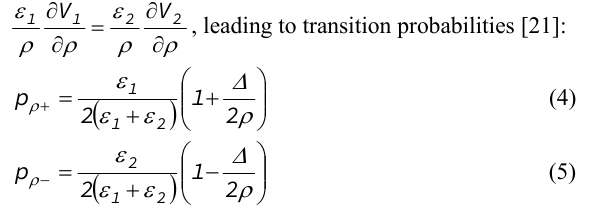
Figure 2. Inhomogeneous Cylindrical Geometry.